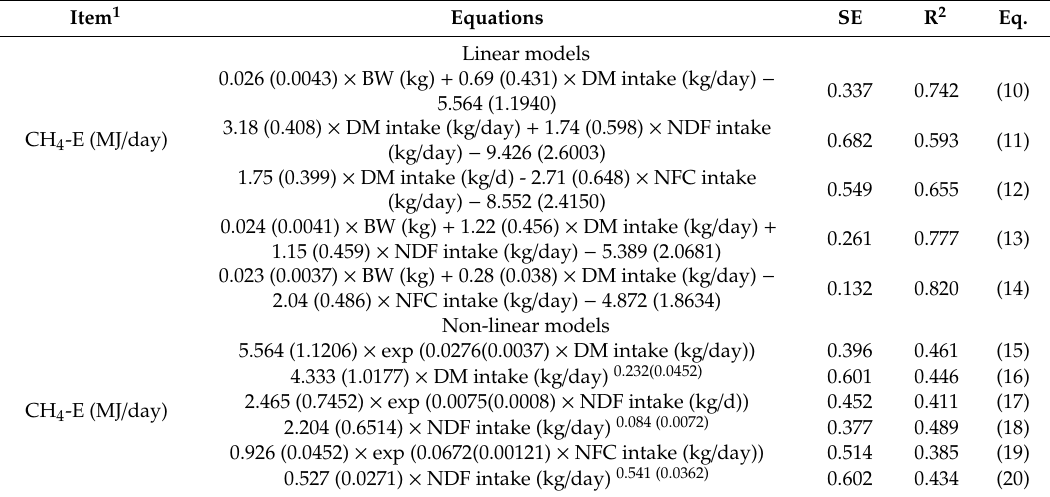
Table 6. Development of methane prediction models for Holstein heifers using the whole data